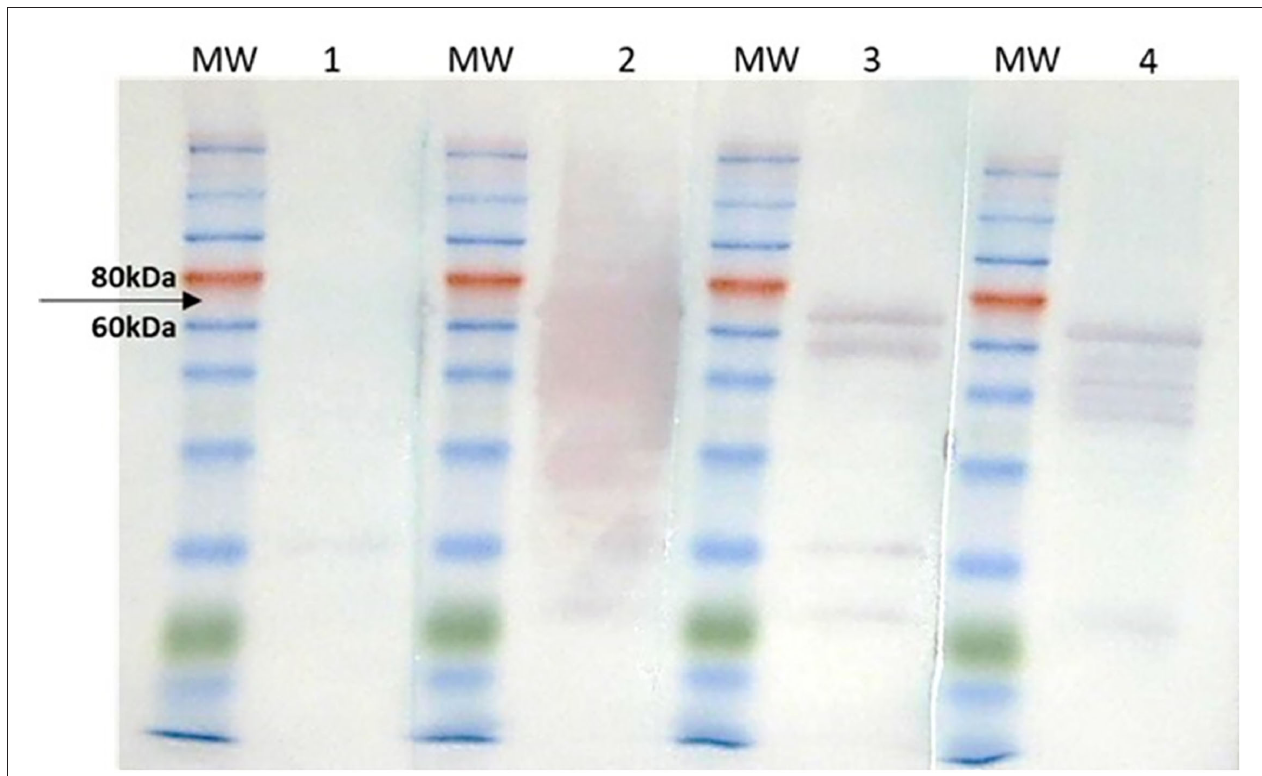
FIGURE 1 | Western blot of purified HTLV-1/HTLV-2 multi-epitope protein. MW, Molecular weight. (1) seronegative pool 1:100/IgG anti-human 1:2,000; (2) positive HTLV-1 pool 1:100/anti-human IgG 1:2,000; (3) positive HTLV-2 pool 1:100 / anti-human IgG 1:2,000; (4) anti-histidine 1:1,500/anti-mouse IgG 1:10,000 (positive control). The black arrow indicates the molecular weight of 70 kDa, corresponding to the size of the recombinant protein. It is observed that the multi-epitope protein was detected by pool sera of individuals infected with HTLV-1 or HTLV-2 (lines 2 and 3, respectively) and by the positive control (line 3—anti-histidine). The pool of seronegative individuals did not react with the target protein (line